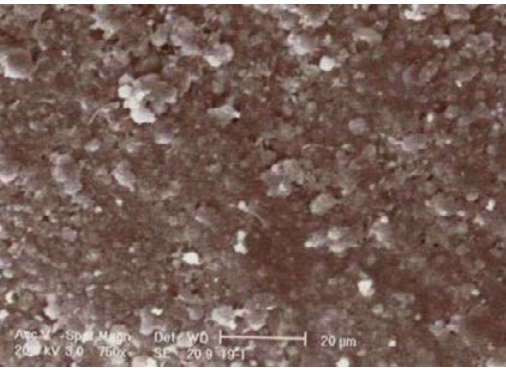
Fig. 6: SEM micrograph of the